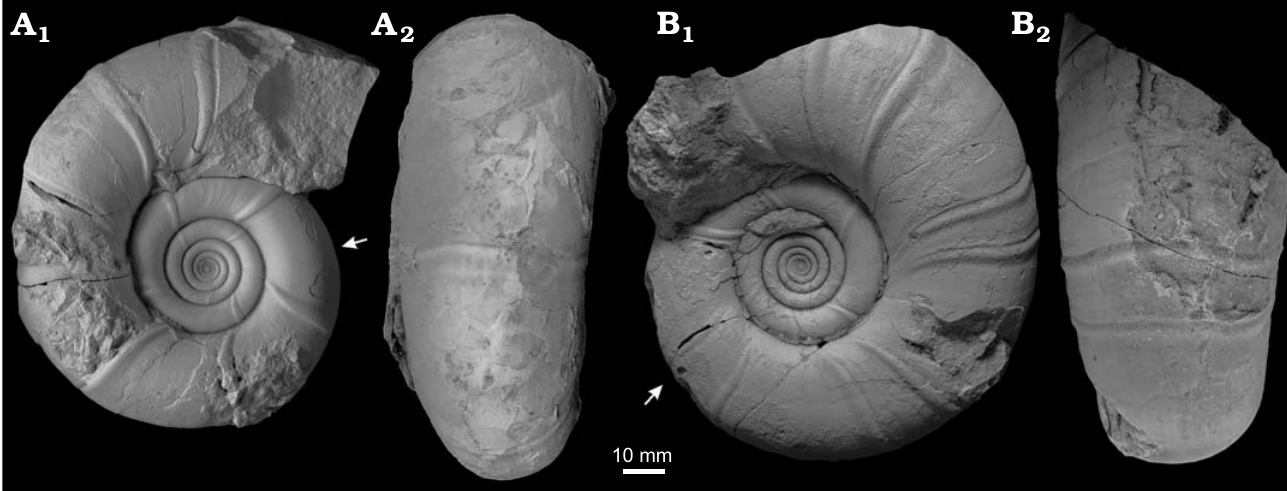
10 Fig. 8. Microconchs of the gaudryceratid ammonoid Anagaudryceras calabozoi Raffi and Olivero sp. nov. from early Campanian (Cretaceous), Antarctica, Rabot Formation, Redonda Point locality. A . CADIC PI 472, holotype, phragmocone and part of the body chamber in lateral (A 1 ) and ventral (A 2 ) views. B . CADIC PI 473, phragmocone and part of the body chamber in lateral (B 1 ) and ventral (B 2 ) views. Arrows mark the beginning of the body chamber.